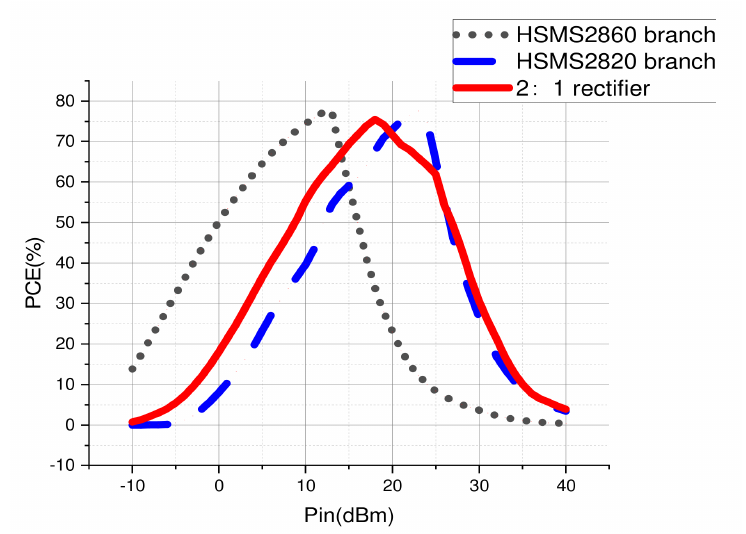
Figure 12. Comparison of the dynamic power range.